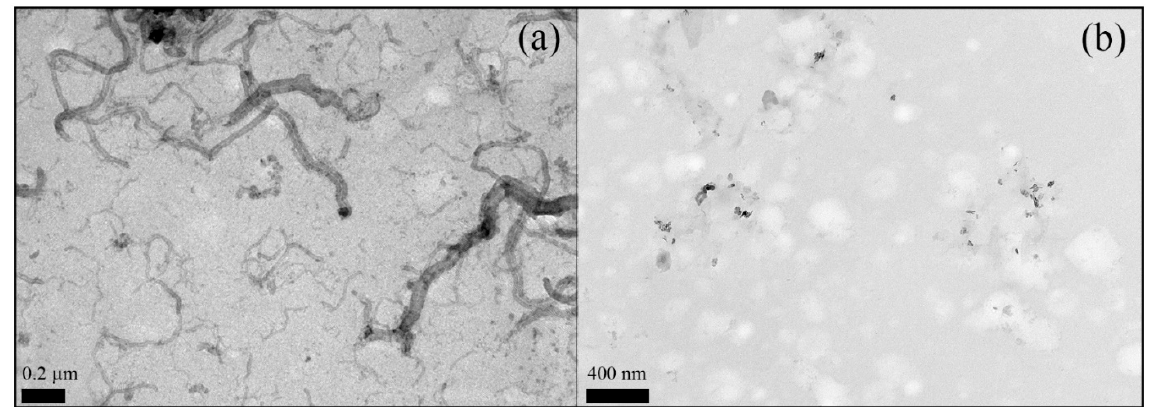
Figure 1. High-resolution (HR)-TEM of pure carbon nanofibers ( a ), TEM ultrathin sections of calcium alginate films with 0.1% w / w of carbon nanofibers ( b ).